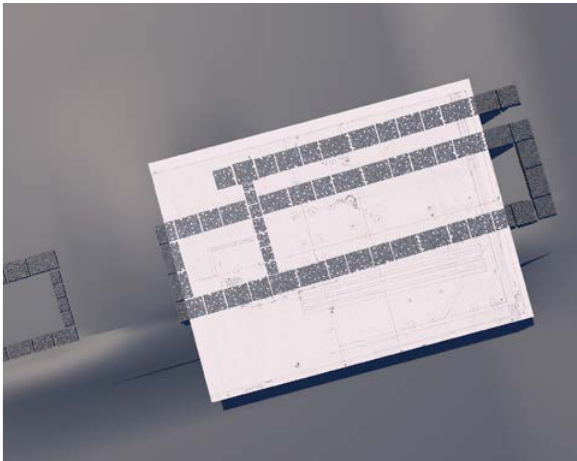
Figure 2. Excavation drawings are imported and build upon (image by L.